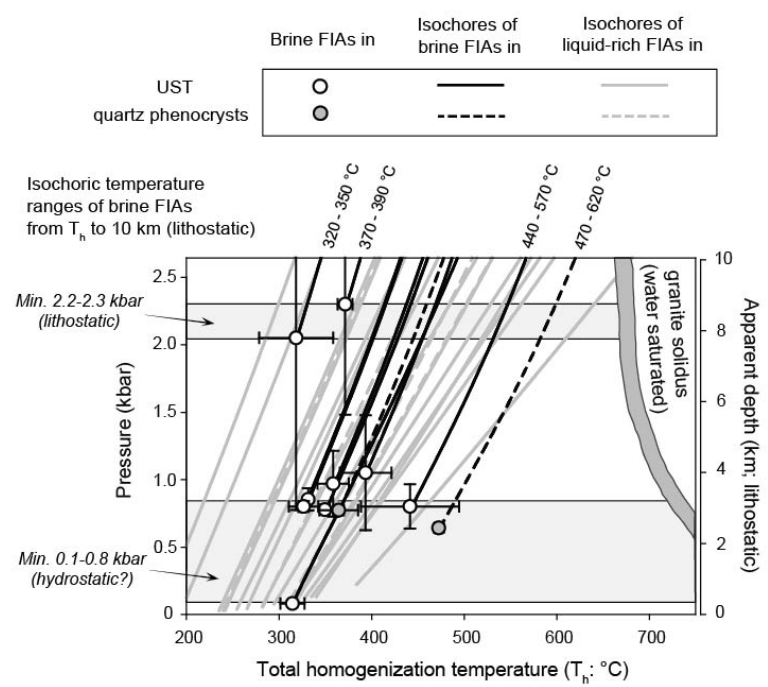
Figure 10. Diagram of P-T information obtained from microthermometry of brine inclusion assem- blages and isochores of liquid-rich and brine inclusion assemblages in the Eonyang UST sample. Two brine assemblages showing the highest minimum pressures (2.2–2.3 kb) can be assumed to be lithostatic, while other assemblages of lower pressures (0.8–1.1 kb) are hydrostatic or transitions of hydrostatic-lithostatic pressures at the same depth. Aqueous fluids of various salinities exsolved at the lithostatic pressure are expected to experience a transient shift in hydrostatic pressure, possibly by hydrofracturing. Transient pressure drop by the hydrostatic-lithostatic transition might cause further magmatic fluid exsolution. Ranges of isochoric temperatures from total homogenization temperatures (T h ) to the temperature of 10 km lithostatic depth obtained from the two highest density brine inclusion assemblages (1.19–1.20 g/cm 3 ) are about 320–350 and 370–390 °C, which are far below the solidus of water-saturated granite [72].